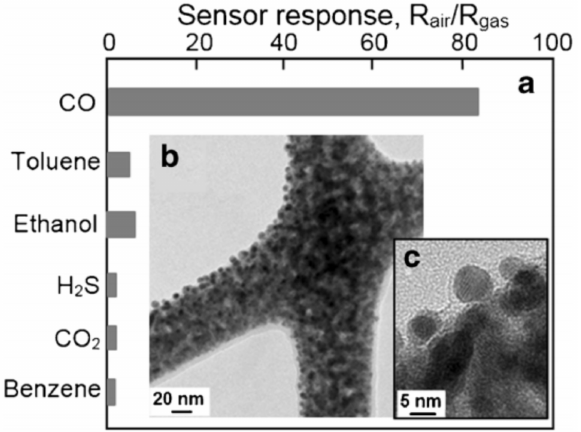
Figure 13. ( a ) Responses of 1.7 at% Au-loaded SnO 2 nanofibers at T oper = 300 ◦ C to various reducing gases (5 ppm), and ( b , c ) typical TEM images of SnO 2 :Au nanofibers. Gold clusters had sizes in the range of 5–10 nm. Adapted with permission from [189]. Copyright 2014 Elsevier.